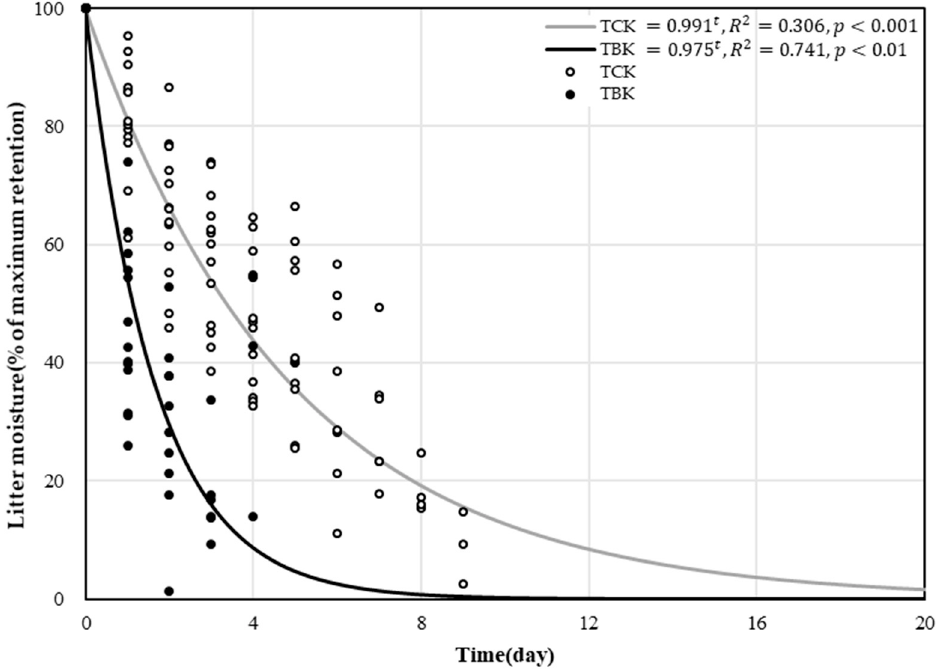
Figure 5. Depletion curve of litter moisture after the cessation of rainfall.